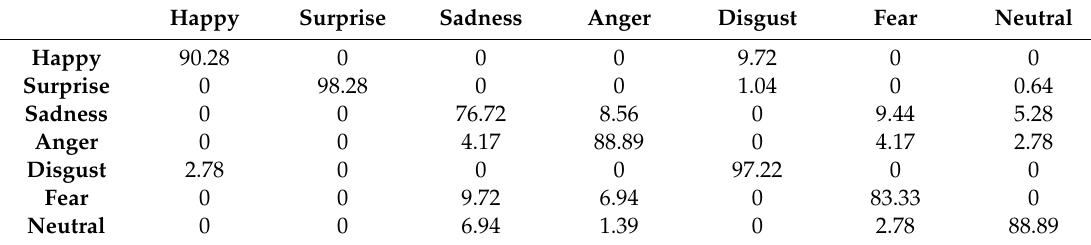
Table 4. Confusion matrix of the KDEF dataset (SVM).